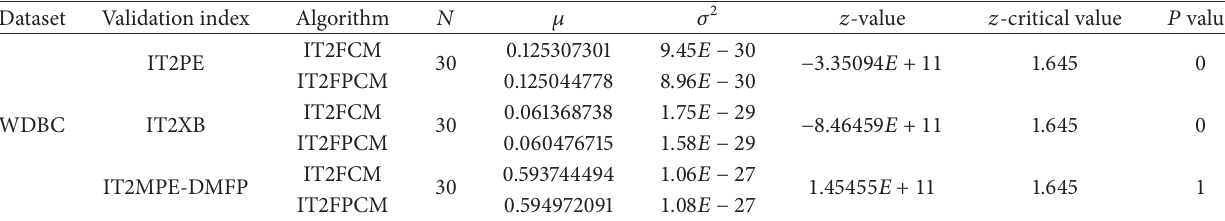
Table 4: Hypothesis testing for the IT2PE, IT2XB, and IT2MPE-DMFP indices of validation for the WDBC dataset clustering. Dataset